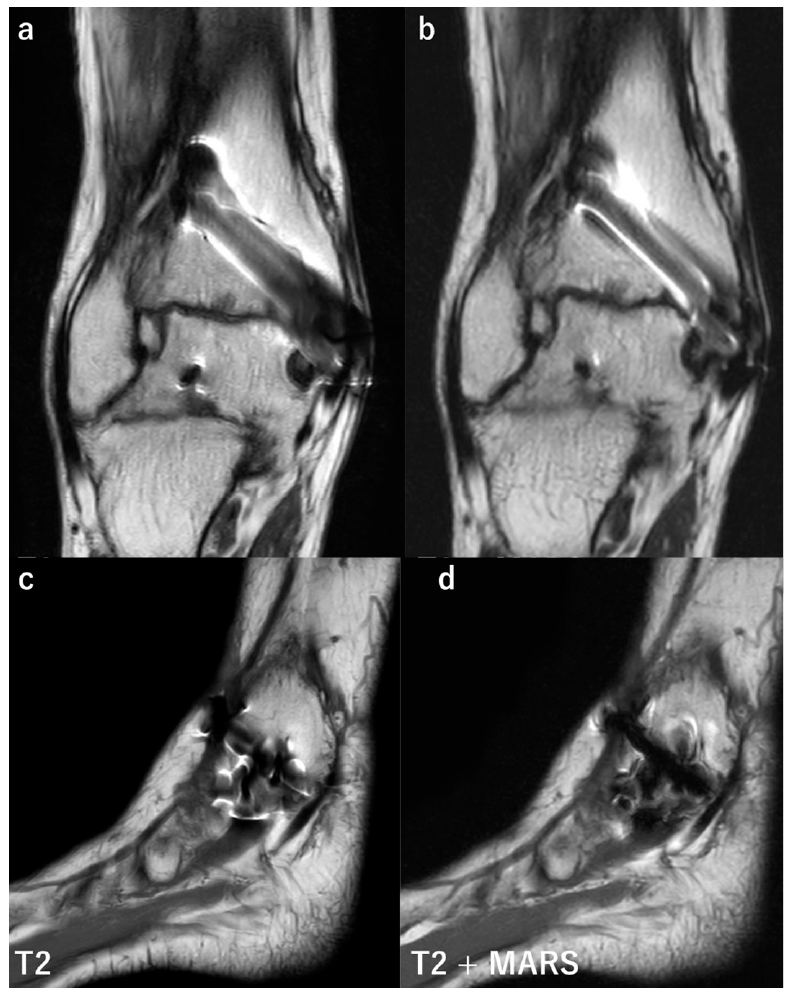
Figure 6. Comparison of conventional MRI and images obtained with MARS. Coronal and sagittal MR images of a patient after medial malleolus fracture of the right ankle. The fracture was treated by a screw fixation. The coronal MR image ( a ) was taken by conventional T2 weighted image (T2WI), and significant signal loss and distortion around the implant are present. Image ( b ) was taken by T2WI with MARS, showing a better visualization of tissue around the screw. The sagittal image ( c , d ) was taken by T2WI, and T2WI with MARS, respectively. Similarly, with coronal images, signal loss and distortion are reduced with MARS, leading to better visualization of tissue surrounding the implant.